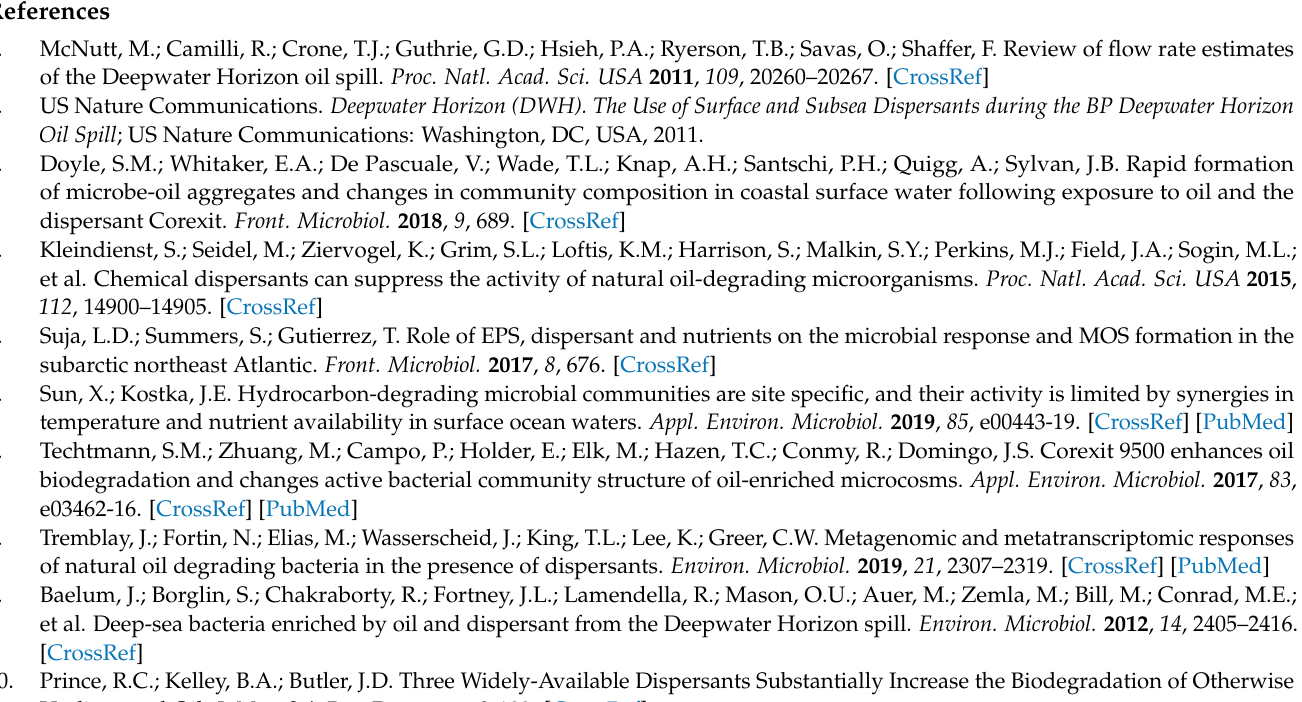
phospholipases, chaperones or oxidative stress; Figure S5: Genetic organization of alginate operons; Figure S6: KEGG orthology annotations; Figure S7: Alginate biosynthesis and export in Marinobacter sp. TT1; Figure S8: Proposed alk operon in Marinobacter sp. TT1 Table S1: Log2-transformed and normalized abundances of all proteins detected; Tables S2–S5 and S7: Proteins with significantly different detected abundances in Marinobacter sp. TT1 growing on different substrates (pairwise comparisons of interest); Table S6: Proteins assigned to non-alkane HC metabolism with significantly higher detected abundances in Marinobacter sp. TT1 growing on Corexit versus hexadecane; Table S8: Proteins assigned to non-alkane HC metabolism with significantly higher detected abundances in Marinobacter sp. TT1 growing on WAF versus CEWAF; Table S9: Proteins of interest detected in this Marinobacter sp. TT1 study and depicted in Figure 2, Figures S4, S7 and